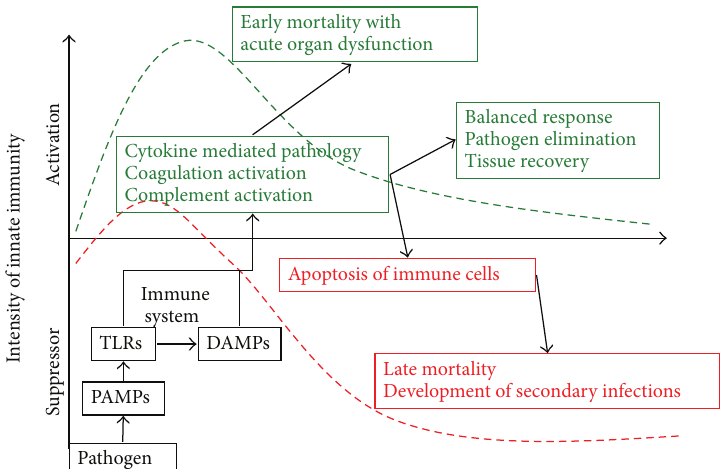
Figure 1: The development of sepsis has two phases, that is, activating and suppressing phase. The activation of the innate immune system can lead to a balanced response that can trigger the elimination of invading pathogens and the recovery of tissue but can also lead to an unbalanced response that can induce hyperinflammation or immune